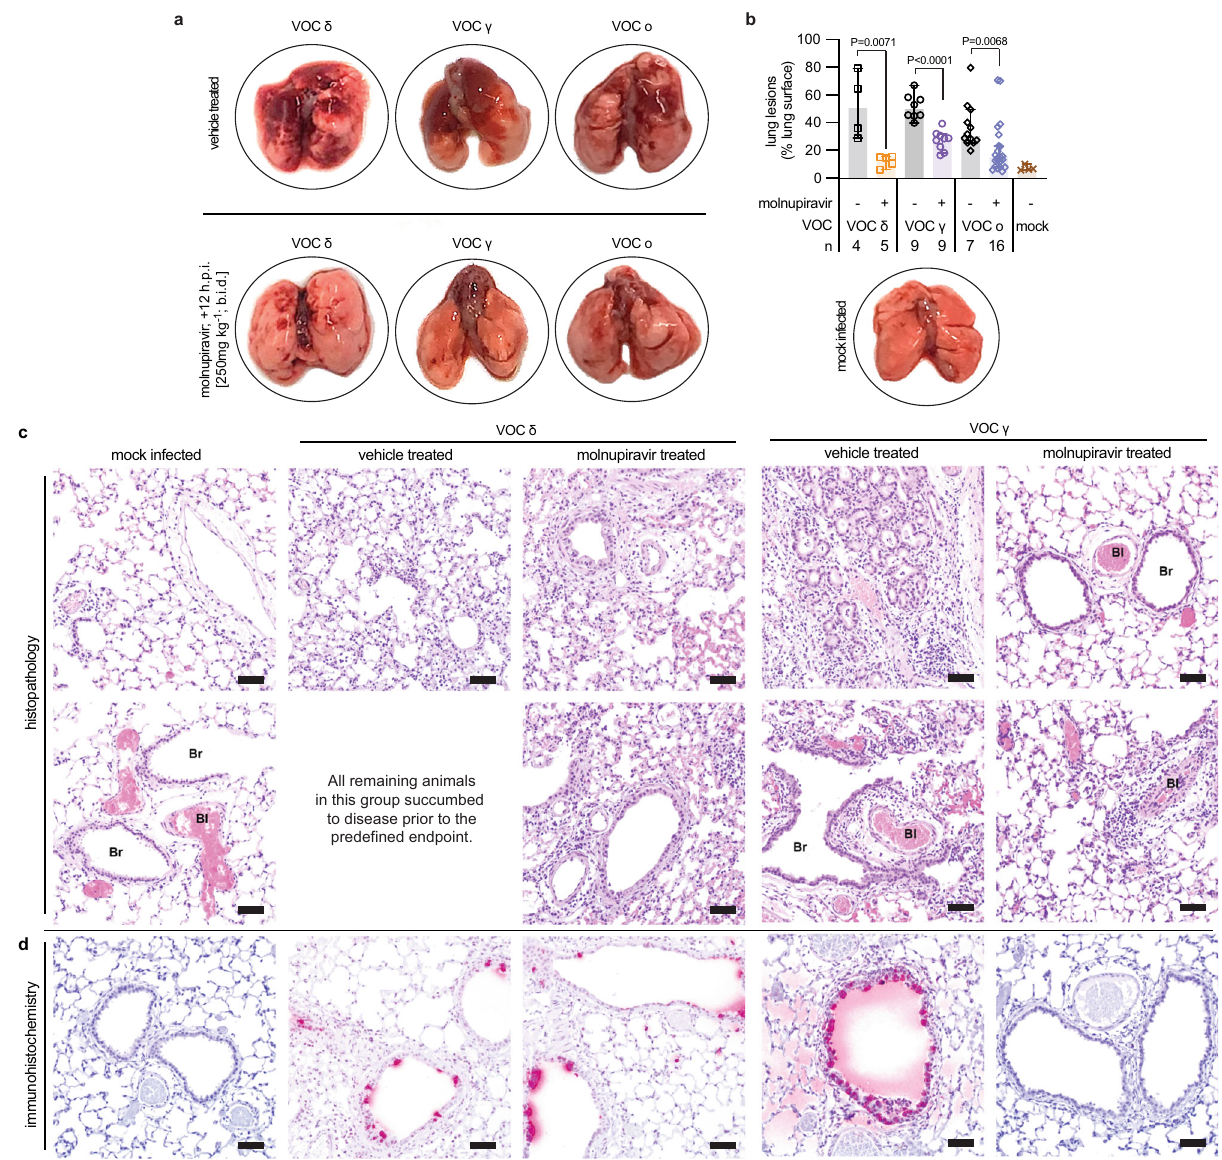
Fig. 6 | Molnupiravir mitigates lung histopathology in VOC-infected dwarf hamsters.a Imagesoflungsfromdwarfhamstersmockinfectedorinoculatedwith 1×10 4 pfu of VOC delta, gamma, or omicron, treated with vehicle or molnupiravir, and harvested 3 days after infection. b Quantitation of macroscopic lesions as a percent of total visible lung surface area for infected dwarf hamsters treated with vehicle or molnupiravir; n values are shown. Mock infected lungs ( n =4) were included as a reference. Symbols represent independent biological